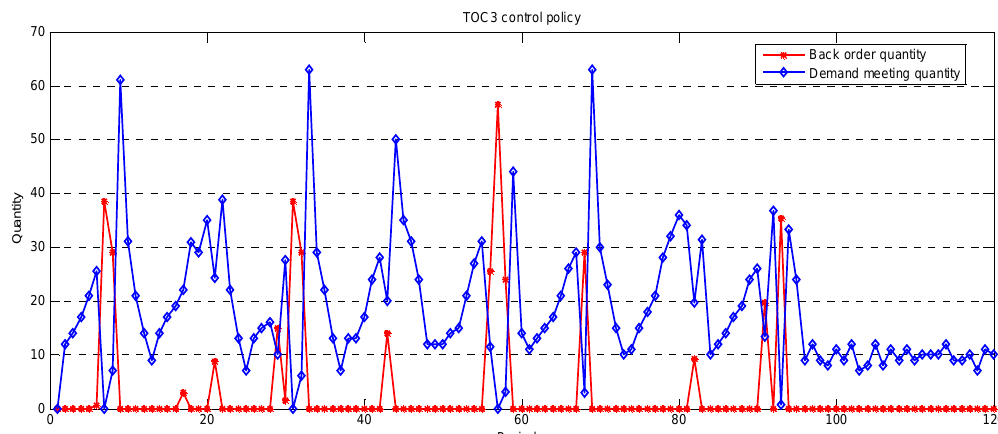
Fig.12. Back order and Demand meeting curve of TOC3 control policy